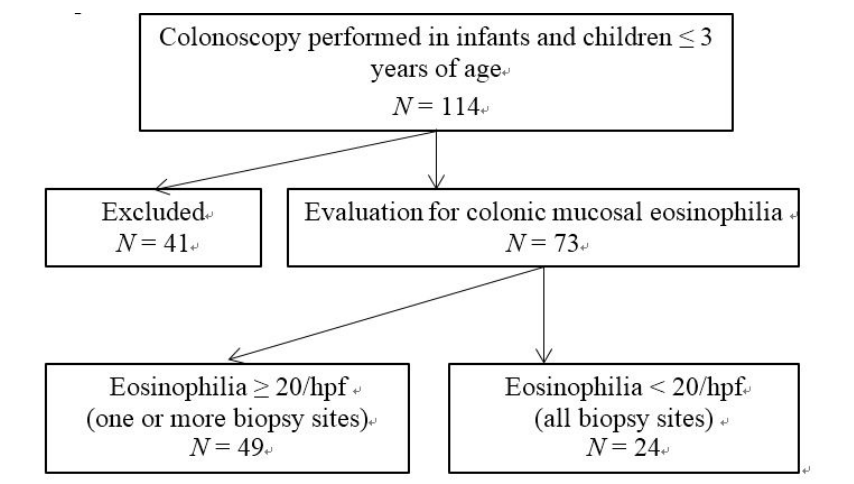
Figure 1. Flow diagram of patient group